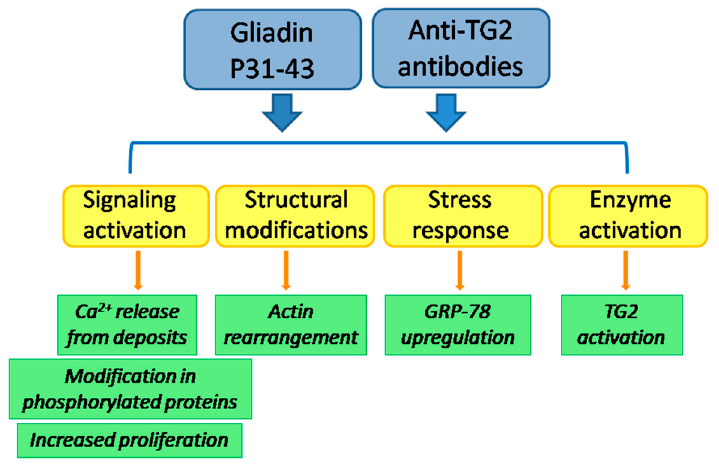
Figure 1. Hypothetical additive or synergic effects of antibodies to TG2 and P31-43 in the environment of CD mucosa.